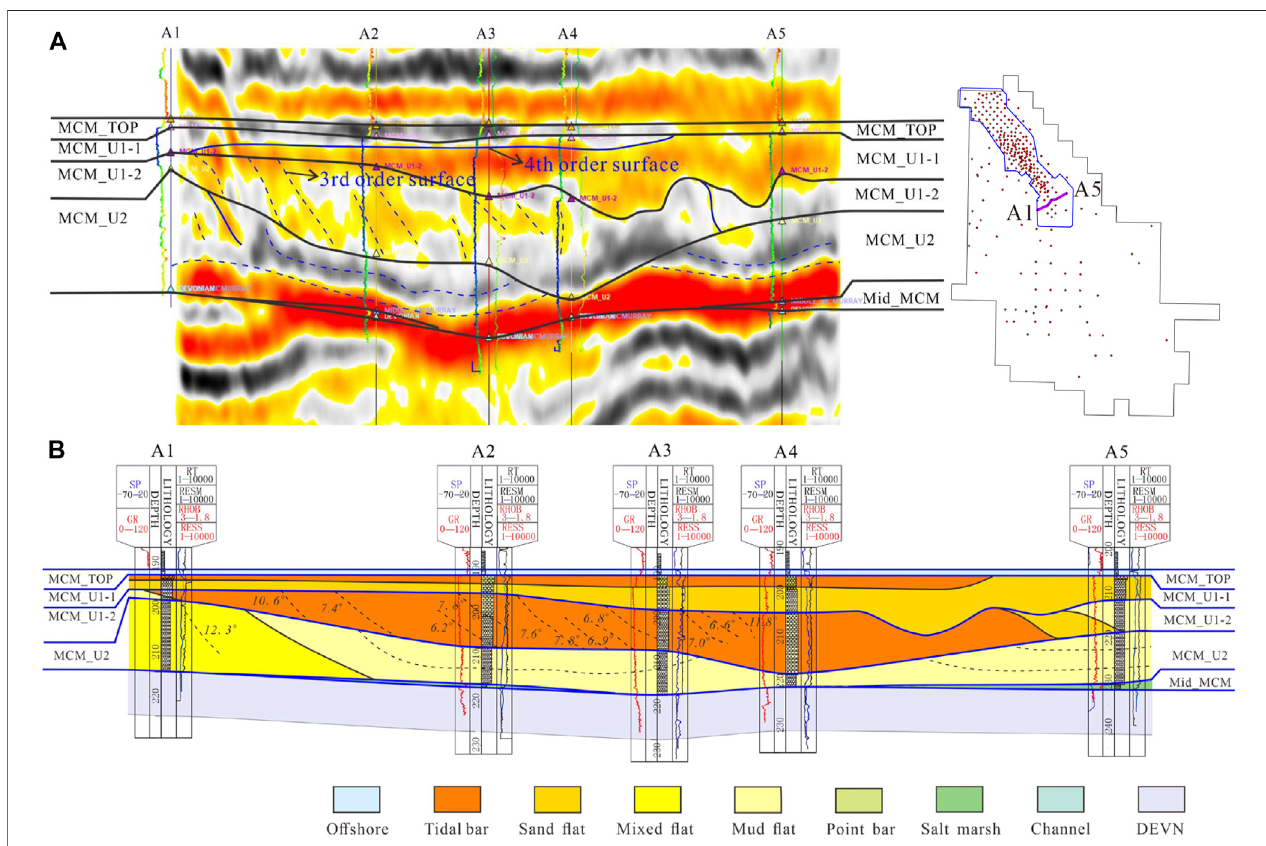
FIGURE4|(A) Theleftoneis2Dseismicpro fi leofthecross-sectionintheverticalprovenancedirection,theGrcurveontherightsideoftheloggingcurve,andthe RESScurveontheleftside.Therightoneisthelocationofthepro fi le. (B) Architectureelementanalysisoftheconnectedwellpro fi leinthedirectionofcuttingprovenance